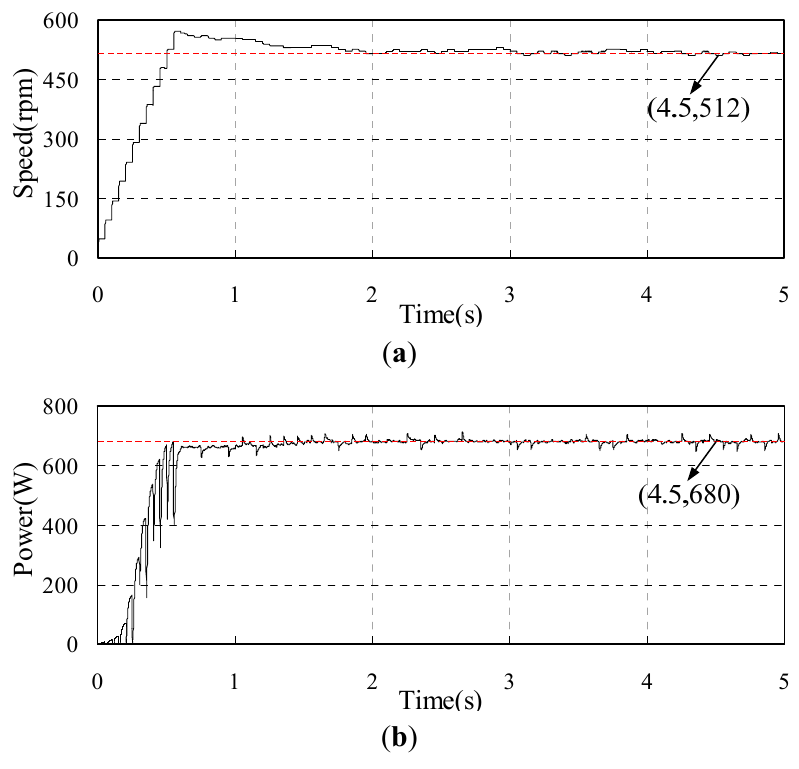
Figure 8. Simulated waveforms of PMSG with HCS MPPT ( a ) Rotor speed of PMSG; ( b ) Output power of